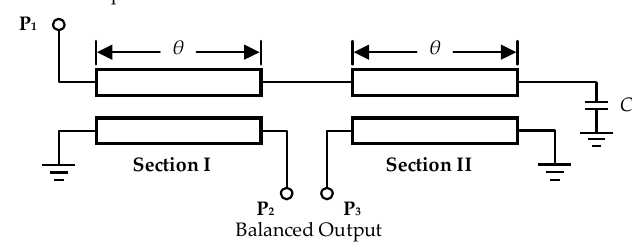
Figure 4. Block diagram of the designed Marchand balun with capacitive termination.